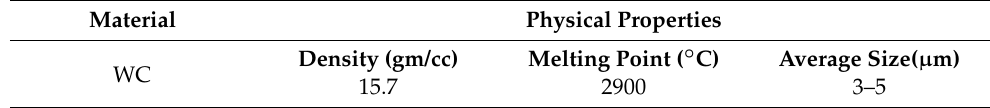
Table 2. Details of physical properties of tungsten carbide particulate. Table 3. Chemical compositional details of tungsten carbide particulate.